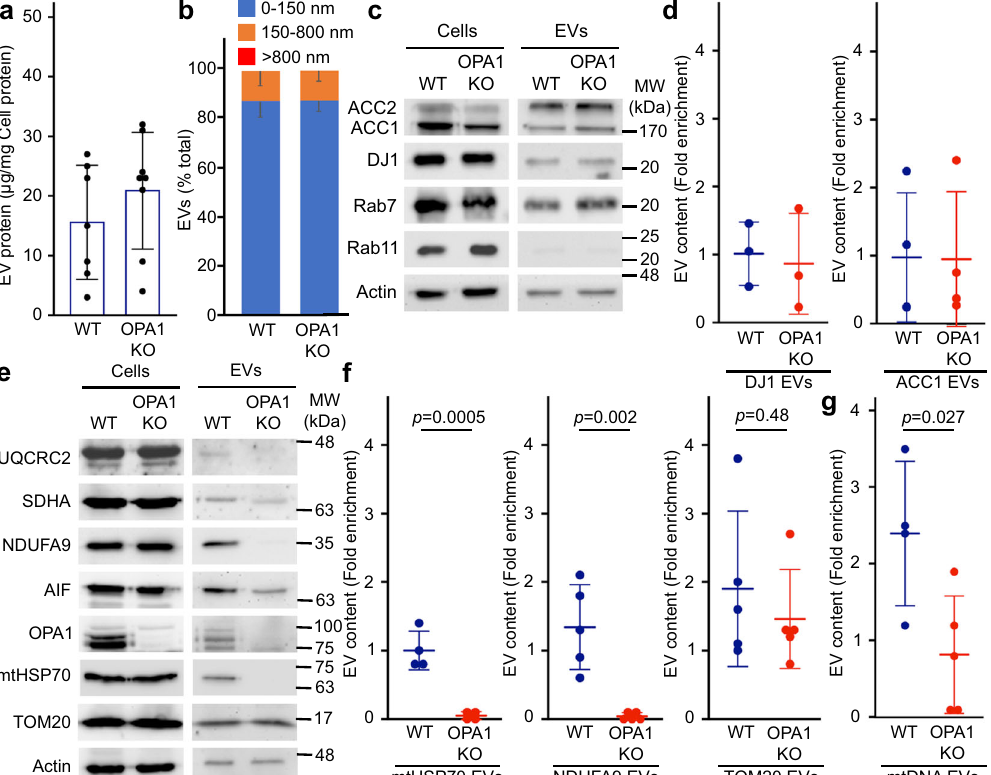
Fig. 5 OPA1 regulates the inclusion of IM/matrix proteins and mtDNA into EVs. a Quanti fi cation of EV protein yields relative to cellular protein content in WT and OPA1 KO EVs isolated as in Fig. 1. Each point represents one experiment ( n = 7). Bars show the average ± SD. b OPA1 deletion does not alter overall EV size. WT and OPA1 KO EV size was analyzed by EM and binned as indicated. The average percent of EVs in each category ± SD is shown ( n = 3). No EVs larger than 800 nm were detected. c , d The inclusion of cytoplasmic proteins into EVs is not altered following OPA1 deletion. Representative western blot ( c ) and quanti fi cation ( d ) as in Fig. 1. Individual points represent independent experiments ( n = 3). Bars show the average ± SD. e – g The inclusion of IM/matrix proteins, but not TOM20, into EVs is prevented by OPA1 deletion. Representative western ( e ) and quanti fi cation as in Fig. 1 ( f ). mtDNA was quanti fi ed by PCR ( g ) Individual points represent independent experiments. Bars show the average ± SD. Two-sided t -test. WT (blue), OPA1 KO